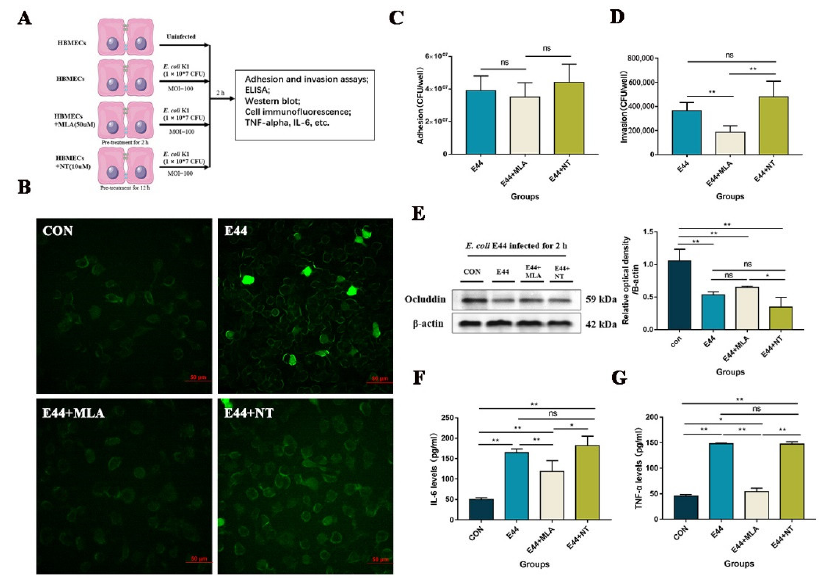
Figure 1. Effects of α 7nAChR agonist (NT) and antagonist (MLA) on HBMECs infected with E. coli E44 in vitro. ( A ) Experiment design in vitro. ( B ) α 7nAChR activation on pre-treated HBMECs infected with E. coli E44 detected by α -BTX assay, conducted by Axio Imager M2 software (Nikon, JPN). ( C ) Adhesive abilities of E. coli E44 infected to HBMECs pretreated with MLA and NT. ( D ) Invasive abilities of E. coli E44 infected to HBMECs cells pretreated with MLA and NT. ( E ) The expression of tight junction protein (Occludin) in HBMECs infected with E. coli E44 treated with MLA and NT, and relative optical density analyzed by Image J. ( F ) The expression of IL-6 in HBMEC cells’ supernatant with MLA and NT when infected with E. coli E44. ( G ) The expression of TNF-α in HBMEC cells’ supernatant. * p < 0.05, ** p < 0.01; NS, no significance.